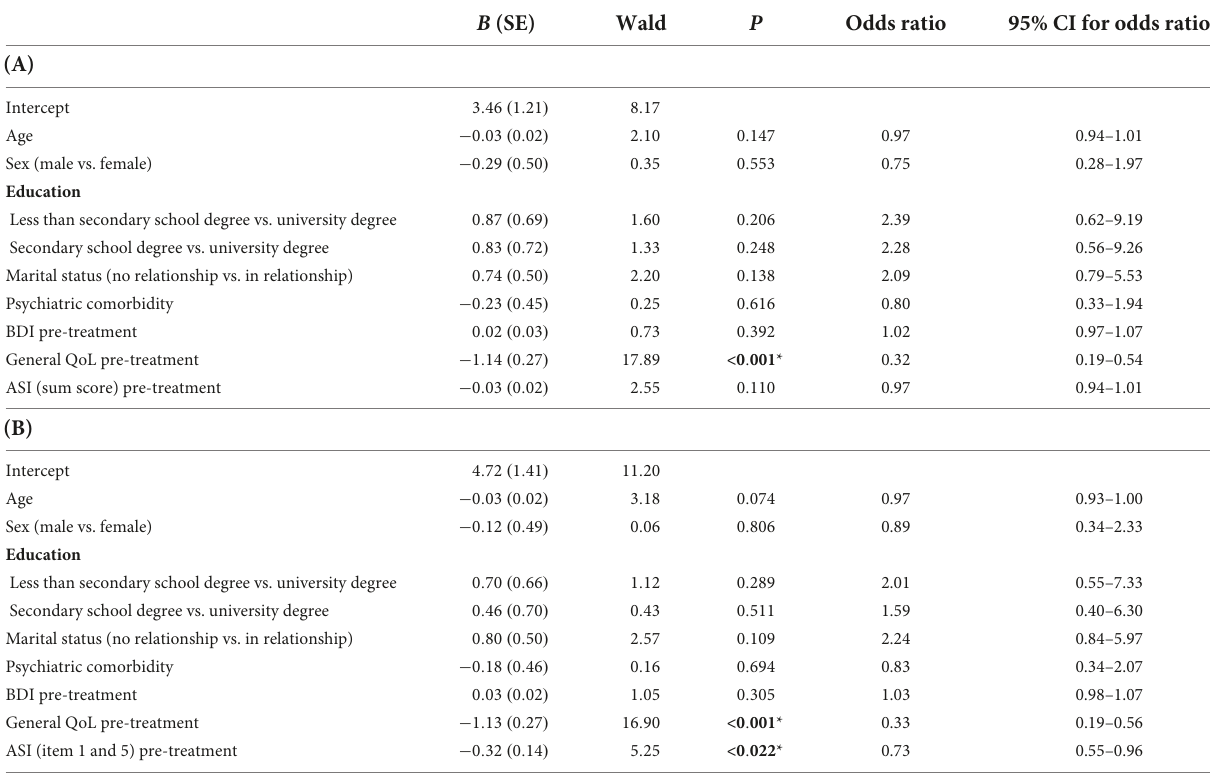
TABLE 6 Prediction of improvement vs. non-improvement in general QoL across